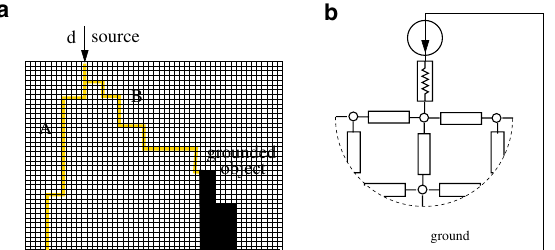
Figure 5. Different geometries. The model can consider, with no essential changes, different geometries. For instance, in the case of a grounded conductive object, the cells corresponding to the object are connected by very small resistance and very large capacitance values: in the left panel, lightning would choose to reach either the ground directly (path A ) or the grounded object (path B ) depending on which is the minimum-threshold path, essentially considering the grounded object a zero cost portion of the path ( a ). Also voltage generators instead of current generators can be considered, without any substantial change, provided that an input resistance is present ( b